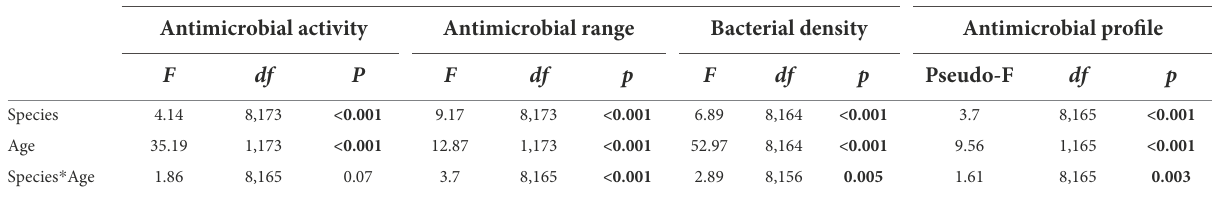
TABLE 2 Results from General Linear Models (GLM) and PERMANOVAs with antimicrobial activity (average values of the width of antagonistic halos when tested against each of the nine indicator bacteria), antimicrobial range (Shannon index of the antimicrobial activity), bacterial density and the antimicrobial profile as dependent